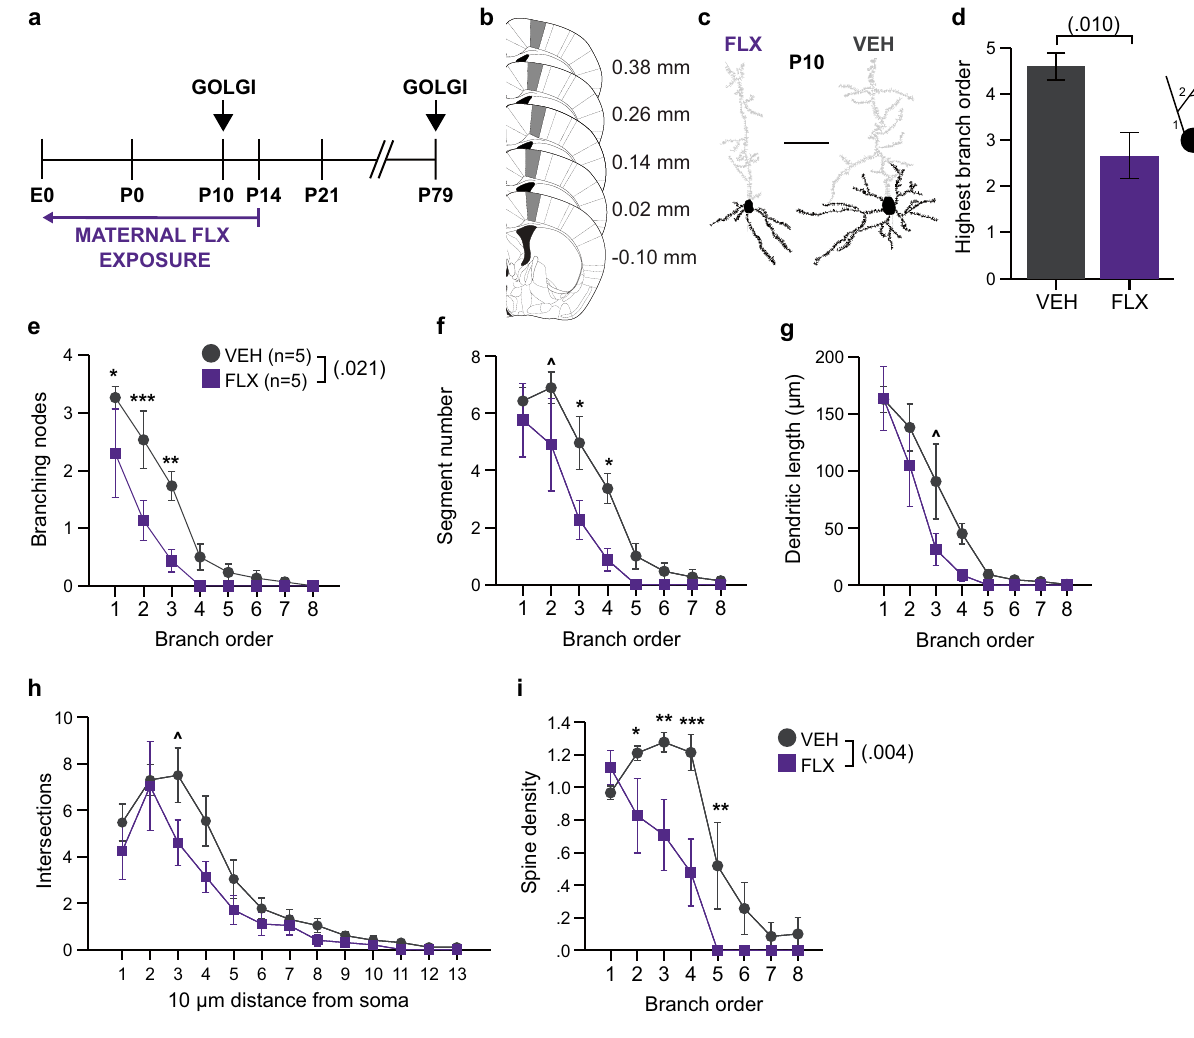
Figure 1. Maternal FLX reduces the extent of basilar dendritic branching and spine density of M1 layer V pyramidal neurons at P10. ( a ) Schematic of the experimental paradigm. ( b ) M1 area used for neuron selection marked in grey; adapted from Franklin and Paxinos, 2008 48 . Numbers indicate distance from bregma. ( c ) Representative tracings of Golgi-Cox impregnated M1 layer V neurons from P10 FLX and VEH brains. Areas in black indicate quantified basilar dendrites and soma. Scale bars are 50 µm. ( d ) FLX neurons did not exhibit the extent of basilar dendritic branching as VEH control neurons at P10 (n = 10 neurons averaged from 5 FLX mice and n = 10 neurons averaged from 5 VEH mice). Inset: schematic of dendritic branch orders, where 1st order branches initiate at the soma, and each subsequent branch order extends from the previous, lower order. ( e ) Fewer basilar branching nodes were observed in FLX-exposed neurons compared to VEH-exposed neurons, with particularly robust deficits at 1st, 2nd, and 3rd branch orders. ( f ) Number of dendritic segments per branch order were reduced in FLX neurons at orders 2, 3 and 4. ( g ) Comparable basilar dendritic length per branch order was observed between FLX- and VEH-exposed neurons. ( h ) Number of intersections with concentric circles per 10 µm distance from the soma as assessed by Sholl analysis did not differ between drug groups. ( i ) FLX-exposed neurons showed significantly reduced spine density over all with the greatest differences occurring at orders 2–5. Data are means ± SEM. Statistical significance, *** p < .001, ** p < .01, * p < .05.